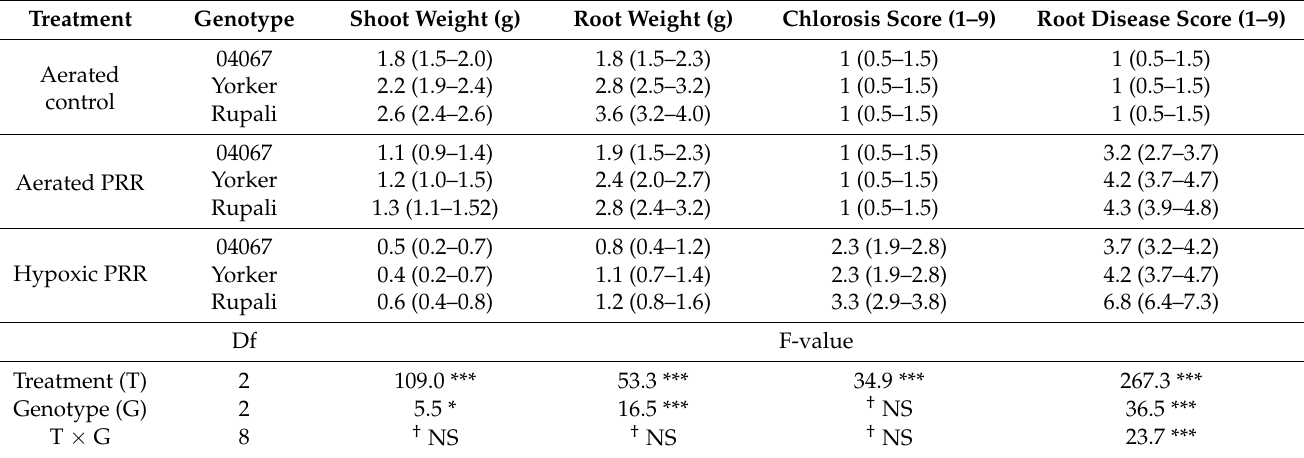
Table 4. Mean values and 5 – 95% CI in parentheses for the two-way GLMM of hypoxia and P. medicaginis treatments on parameters for three chickpea genotypes C. echinospermum moderately resistant 04067, C. aretinum moderately susceptible Yorker and very susceptible Rupali grown in hydroponic solution.